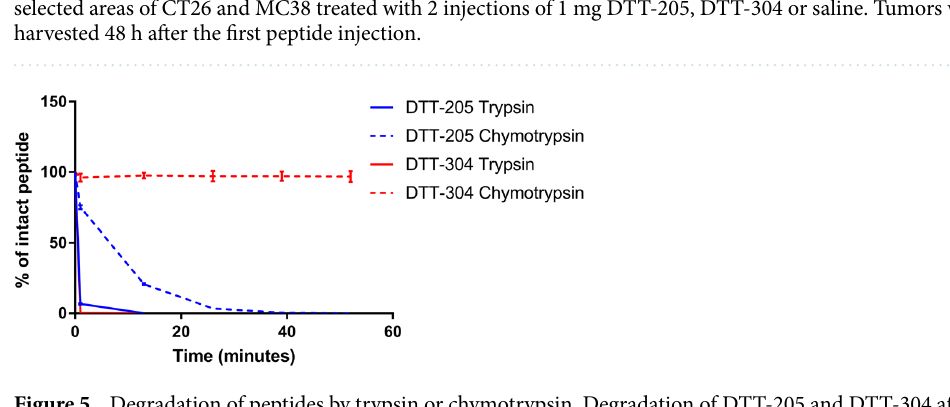
Figure 5. Degradation of peptides by trypsin or chymotrypsin. Degradation of DTT-205 and DTT-304 after administration of trypsin or chymotrypsin every 13 min, shown as % of remaining peptide. Error bars indicate standard